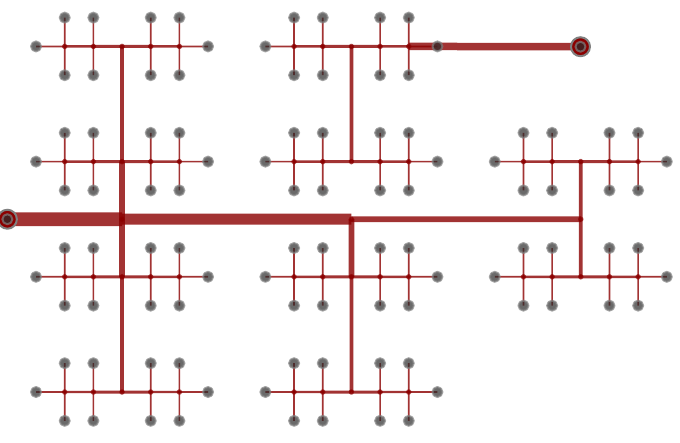
Figure A6. Generic separation scenario 2.